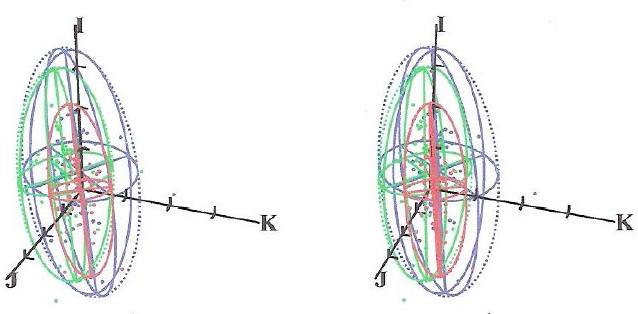
Figure 4: Stereo-pair scatter plot of fifty measurements of re- fractive state taken from subject 3. The origin of the axes is at −0.5 I D.